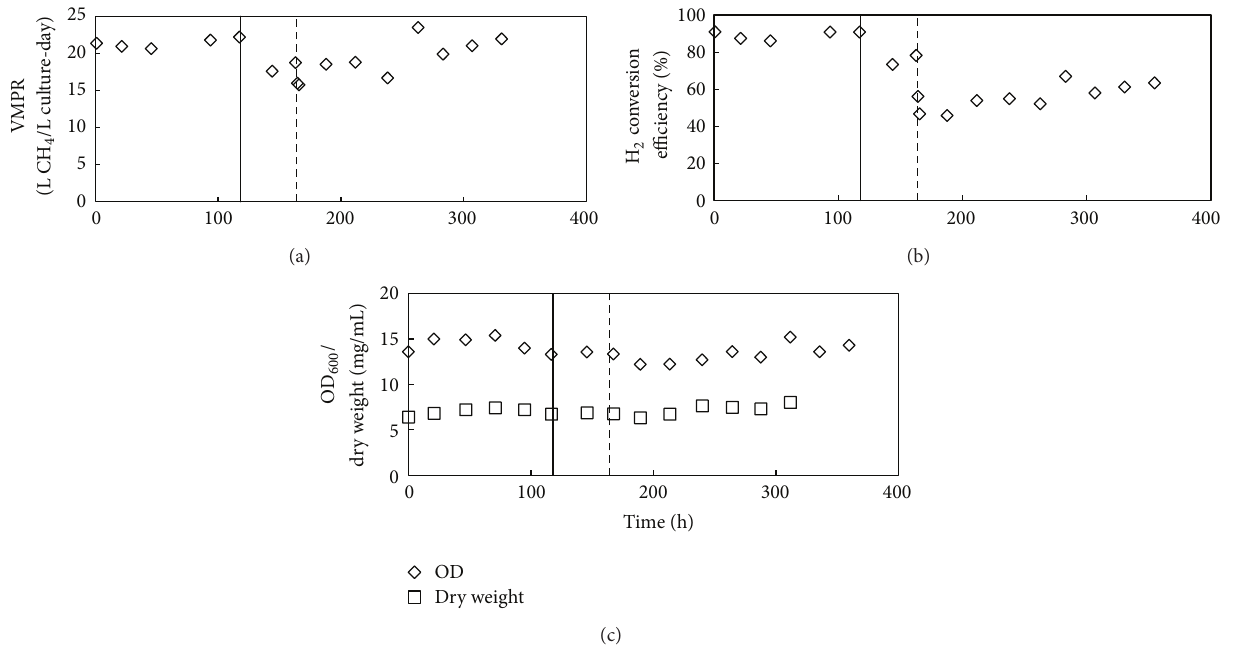
Figure 5: Bioreactor performance for Experiment 4. Volumetric methane production rates (a), hydrogen conversion efficiencies (b), and biomass concentrations (c) during one bioreactor run. The bioreactor was moved from the laboratory to the industrial site on hour 117 of the operating period (straight line) while untreated biogas was introduced instead of synthetic CO 2 on hour 164 of the operating period (dotted